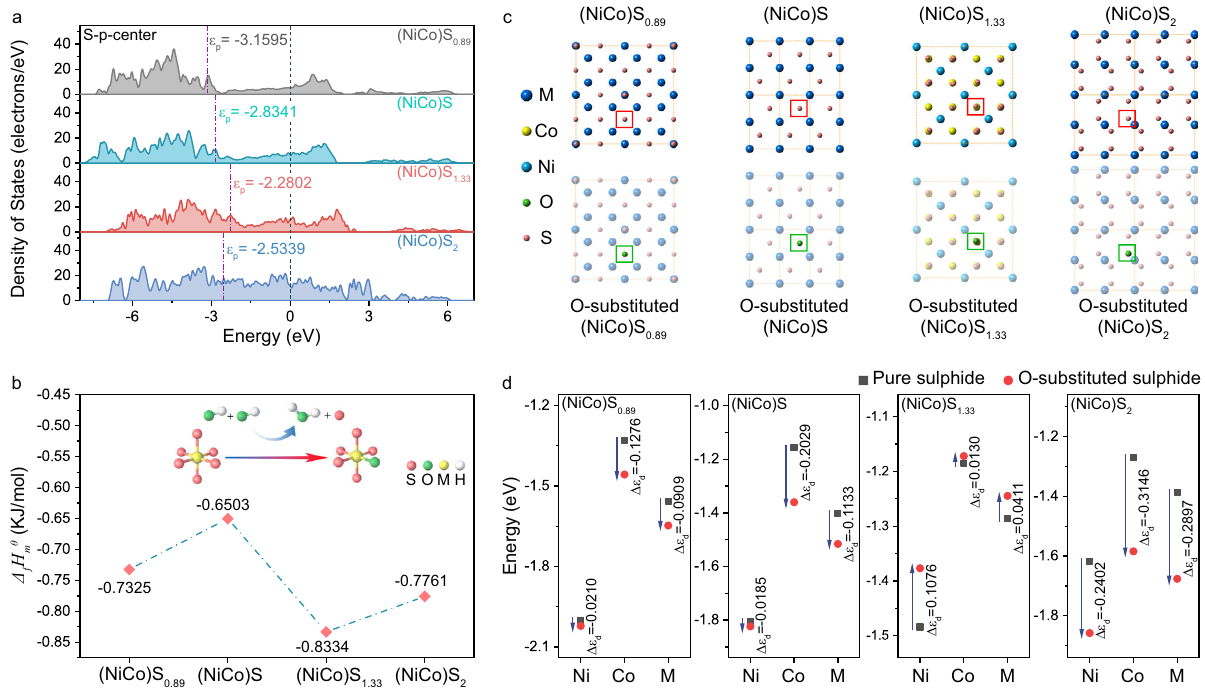
Fig.4|Originandin fl uenceofthelatticesulphur-oxygensubstitutionprocess. a p-band centre of S in (NiCo)S 0.89 , (NiCo)S, (NiCo)S 1.33 and (NiCo)S 2 . b Formation enthalpy of replacing the lattice sulphur S with O atom in (NiCo)S 0.89 , (NiCo)S, (NiCo)S 1.33 and (NiCo)S 2 . c Schematic diagram of the pure sulphides and